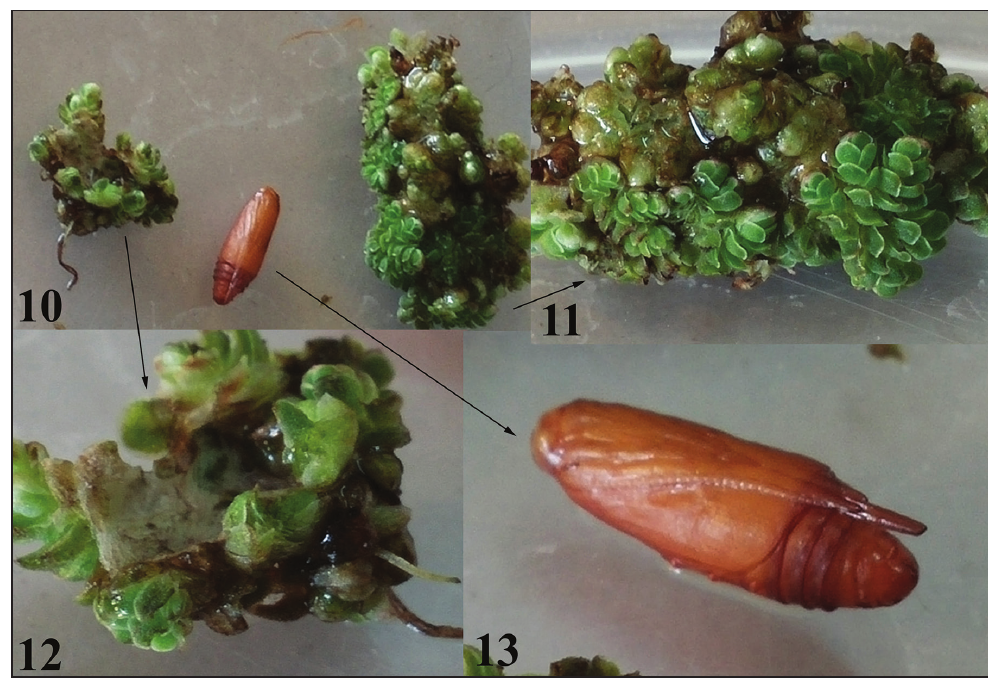
Figures 10–13. Cataclysta lemnata pupa. 10. Pupa; 11. Pupal shelter; 12. Inside the pupal shelter with a silky layer; 13. Pupa with chimney-like stigma.